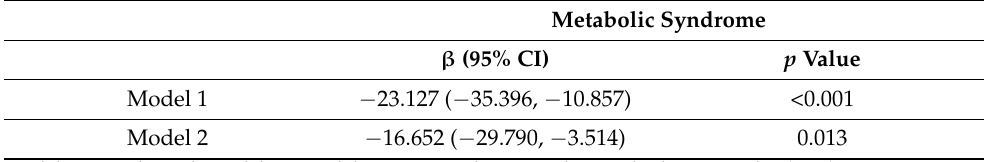
Table 2. Relation between klotho and metabolic syndrome.